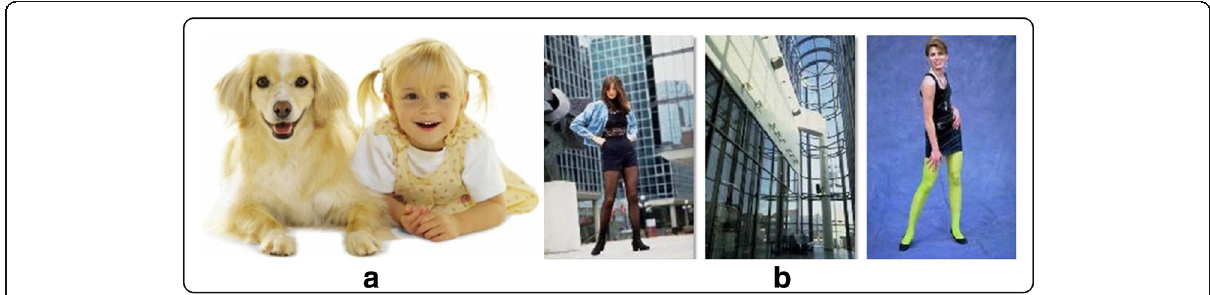
Fig. 2 a Image with very close visual appearance but with a different semantic meaning. b The image on the left is the inquiry image, while the image of building and lady are the retrieved images in reply to the inquiry image due to close visual